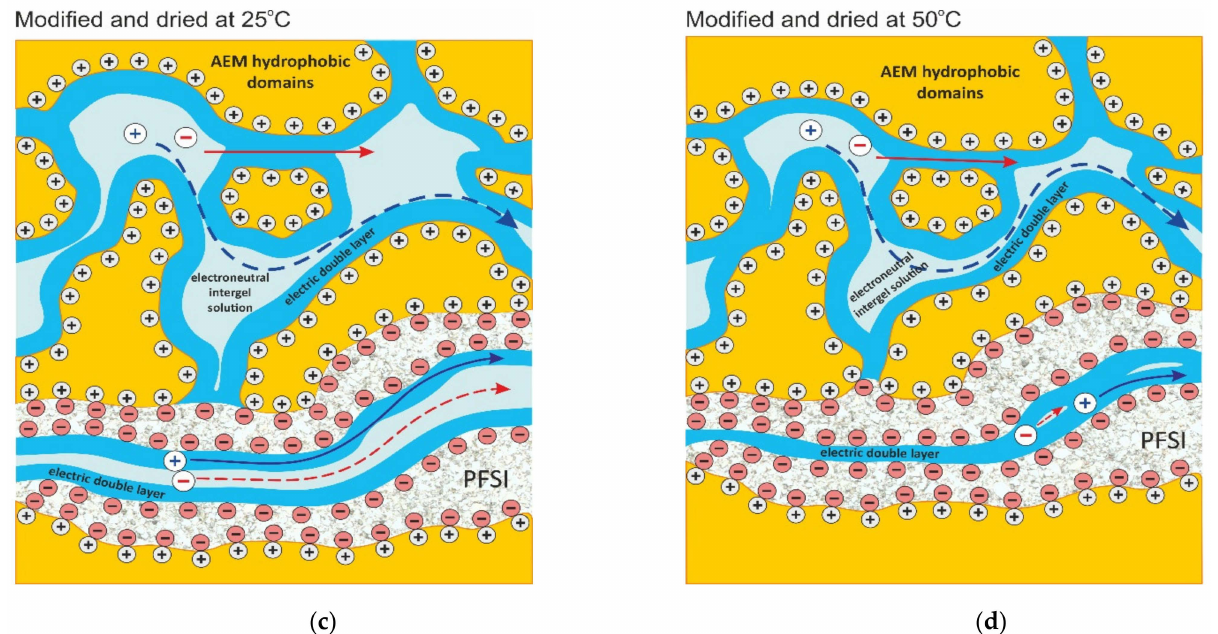
Figure 2. Schematic representation of the changes in studied membrane structure at different stages of its treatment: ( a ) CJMA-7 pr , ( b ) CJMA-7 fr , ( c ) CJMA-7 fr-mod25 and ( d ) CJMA-7 fr-mod50 . The